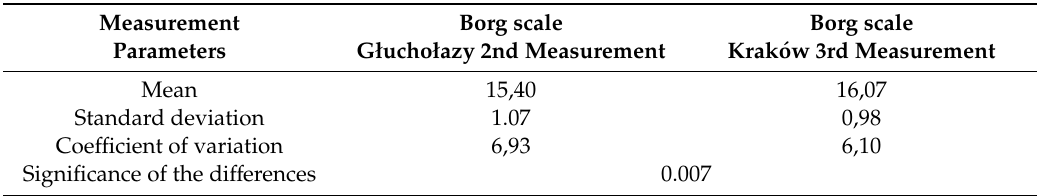
Table 8. Assessment of the subjective level of fatigue of the tested individuals in the Borg scale for the 2nd study in Głuchołazy and the 3rd study in